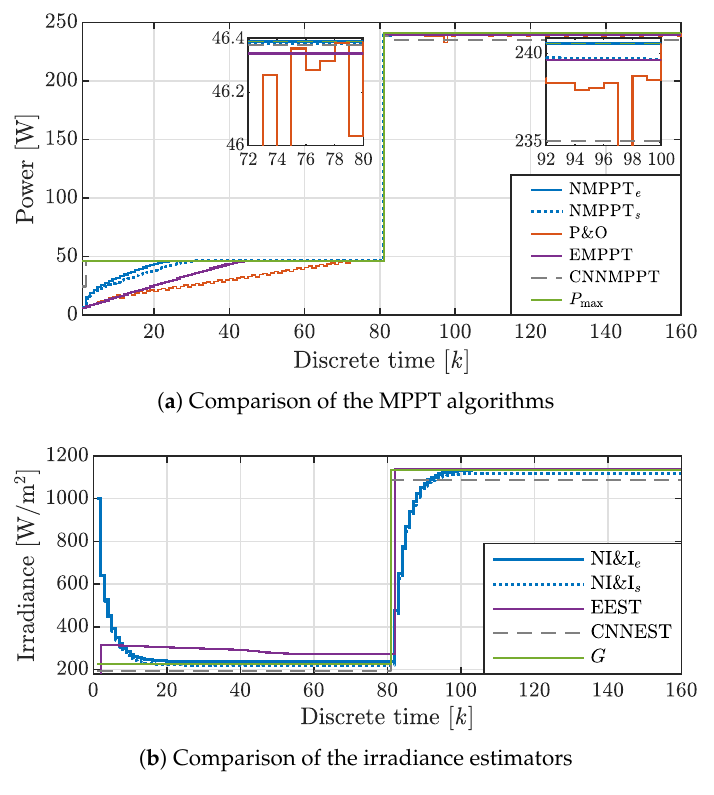
Figure 12. Comparison of the algorithms under sudden change in irradiance.